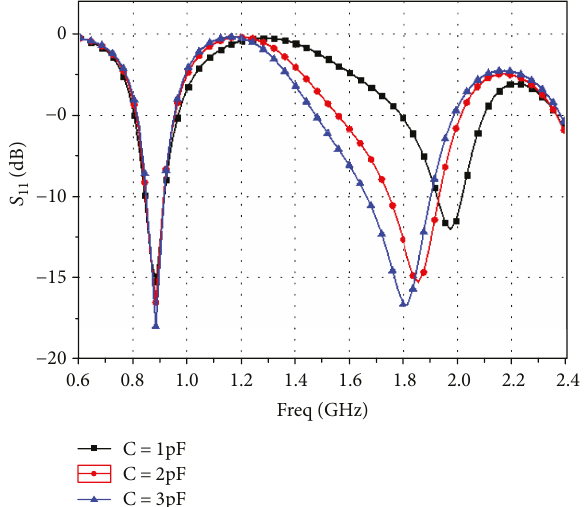
Figure 4: Simulated and measured S ff erent capacitances. Figure 3: Simulated S Koch fractal-shaped monopole 11 of the antenna with di